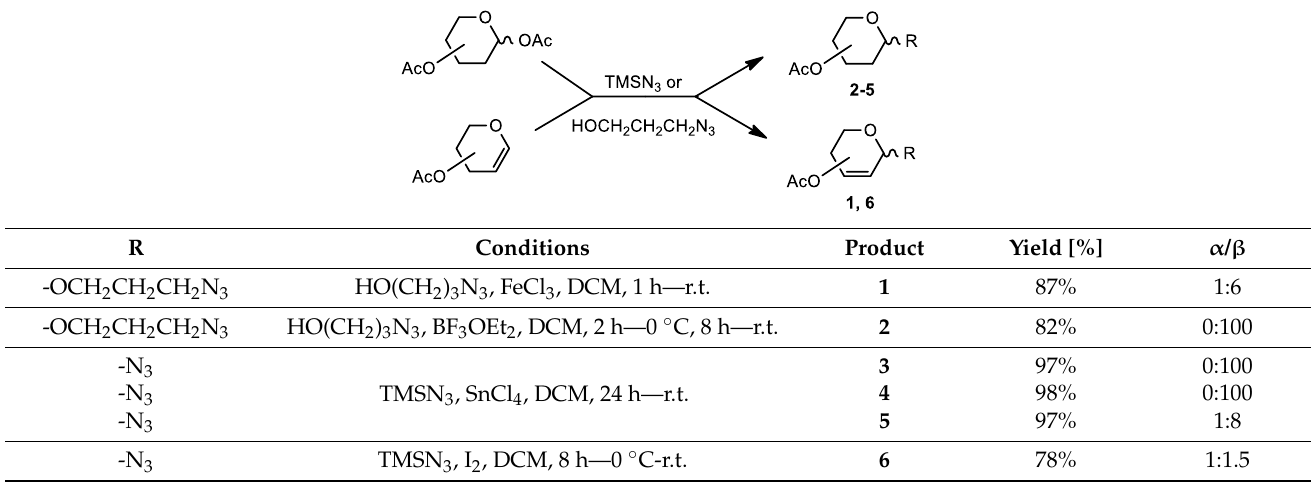
Table 1. Reaction conditions to obtain azide derivatives of sugars ( 1 – 6 ).